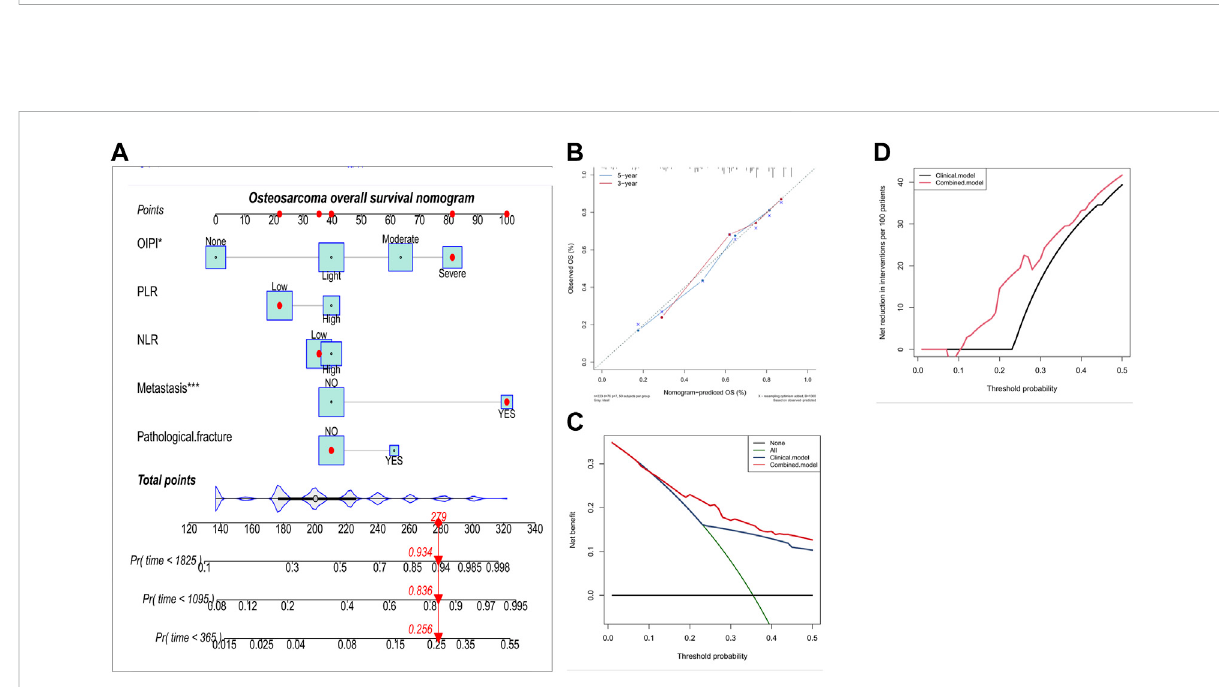
FIGURE 5 Construction and validation of the osteosarcoma overall survival nomogram. (A) The nomogram was constructed by combing OIPI, PLR, NLR, metastasis and pathological fracture and the sum of the scores for each covariate was the nomogram total score. (B – D) This nomogram was validated by the calibration curve, decision curve analysis, and clinical impact curve. OIPI, osteosarcoma immune prognostic index; PLR, platelet – lymphocyte ratio; NLR; neutrophil – lymphocyte